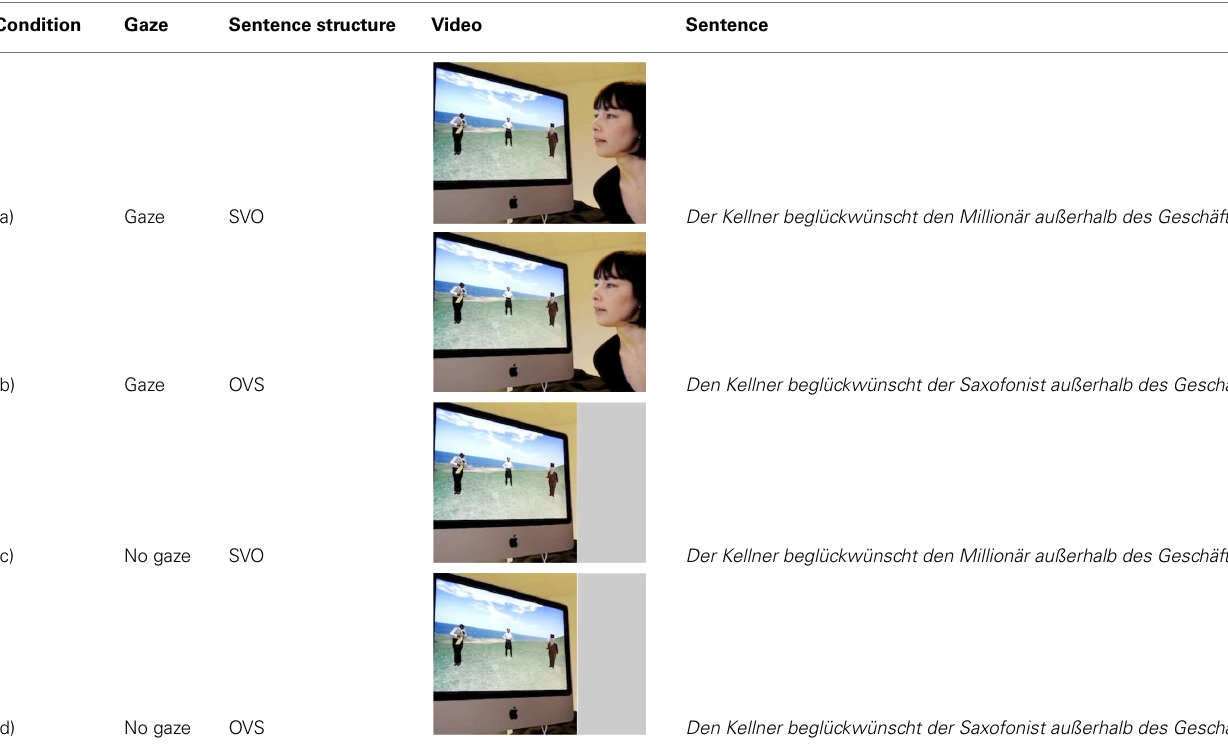
Table 1 | Overview of the experimental conditions (congruence is not